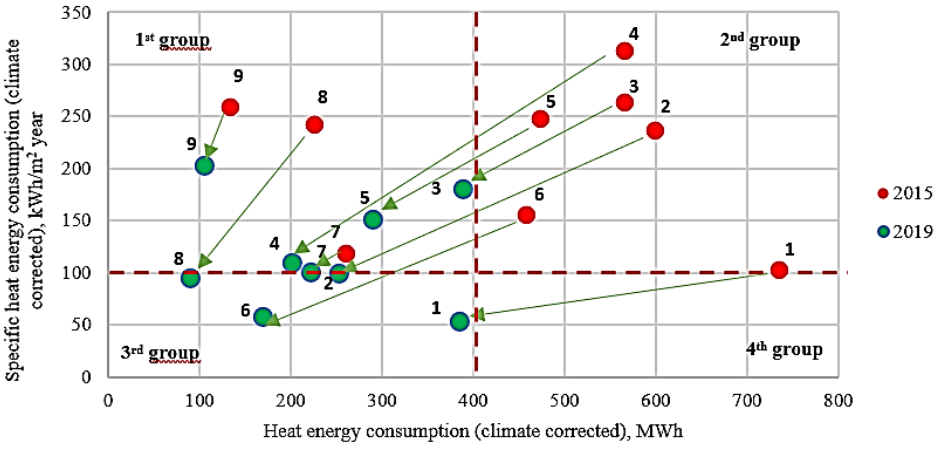
Fig. 8. Heat energy consumption at 9 municipal buildings of the city of Daugavpils which were renovated during 2016– 2018.